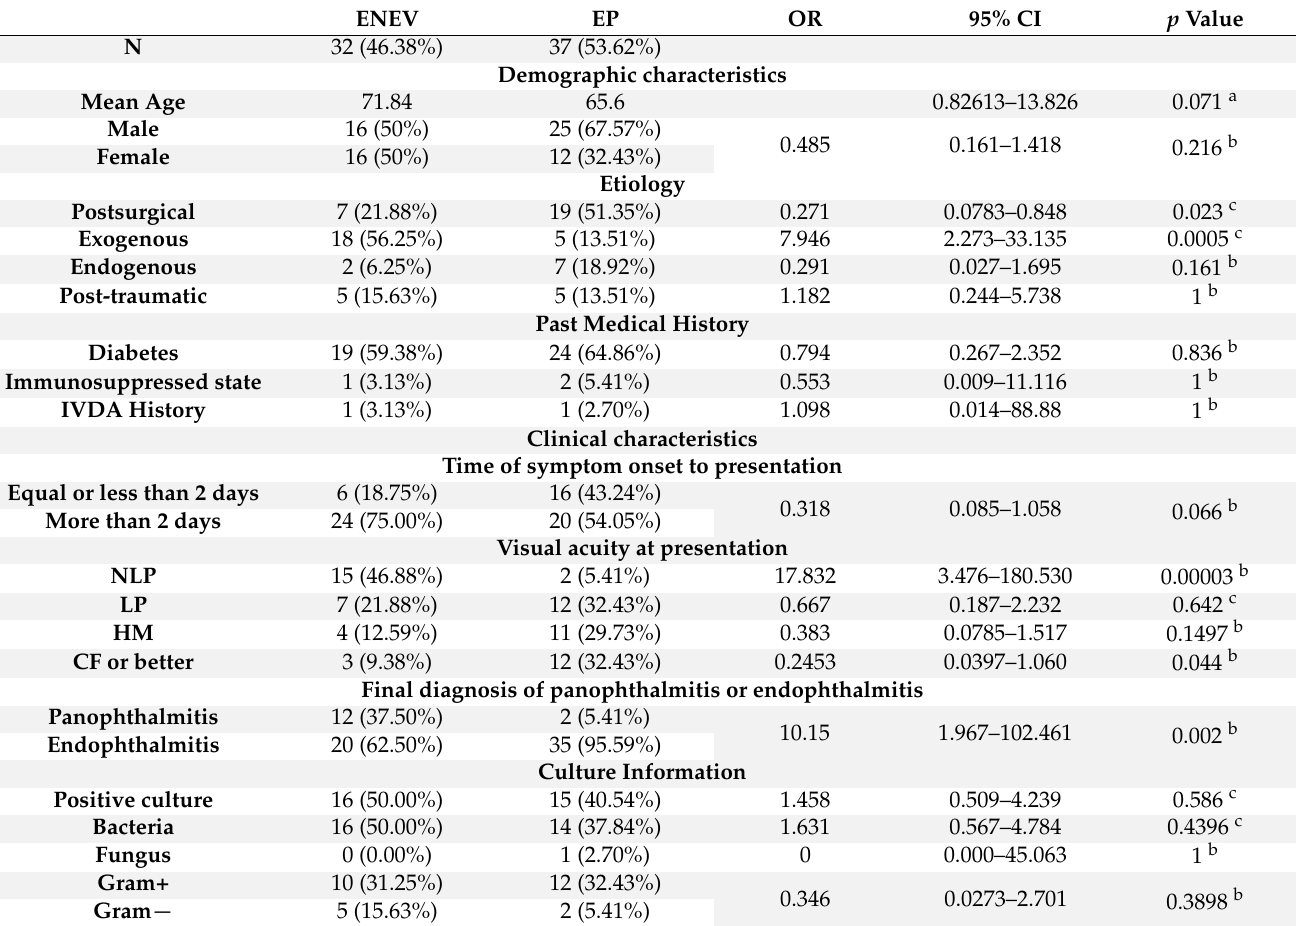
Table 2. Comparison of Characteristics of ENEV Group vs. EP